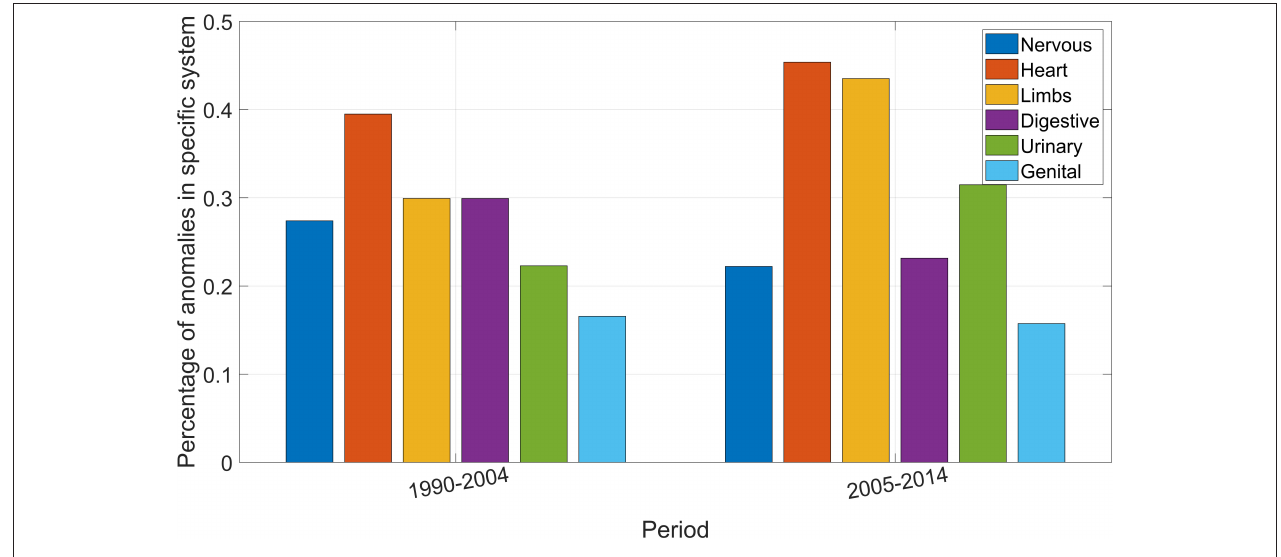
FIGURE 3 | Percentage of congenital anomalies in respective organ